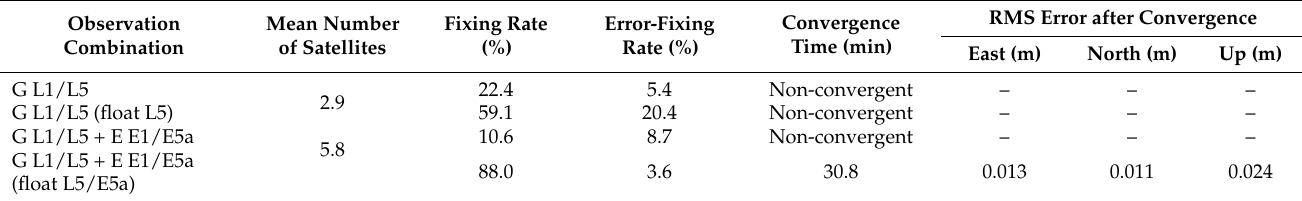
Table 7. Solutions of dual-frequency combinations. The mean number of satellites only includes dual-frequency satellites.